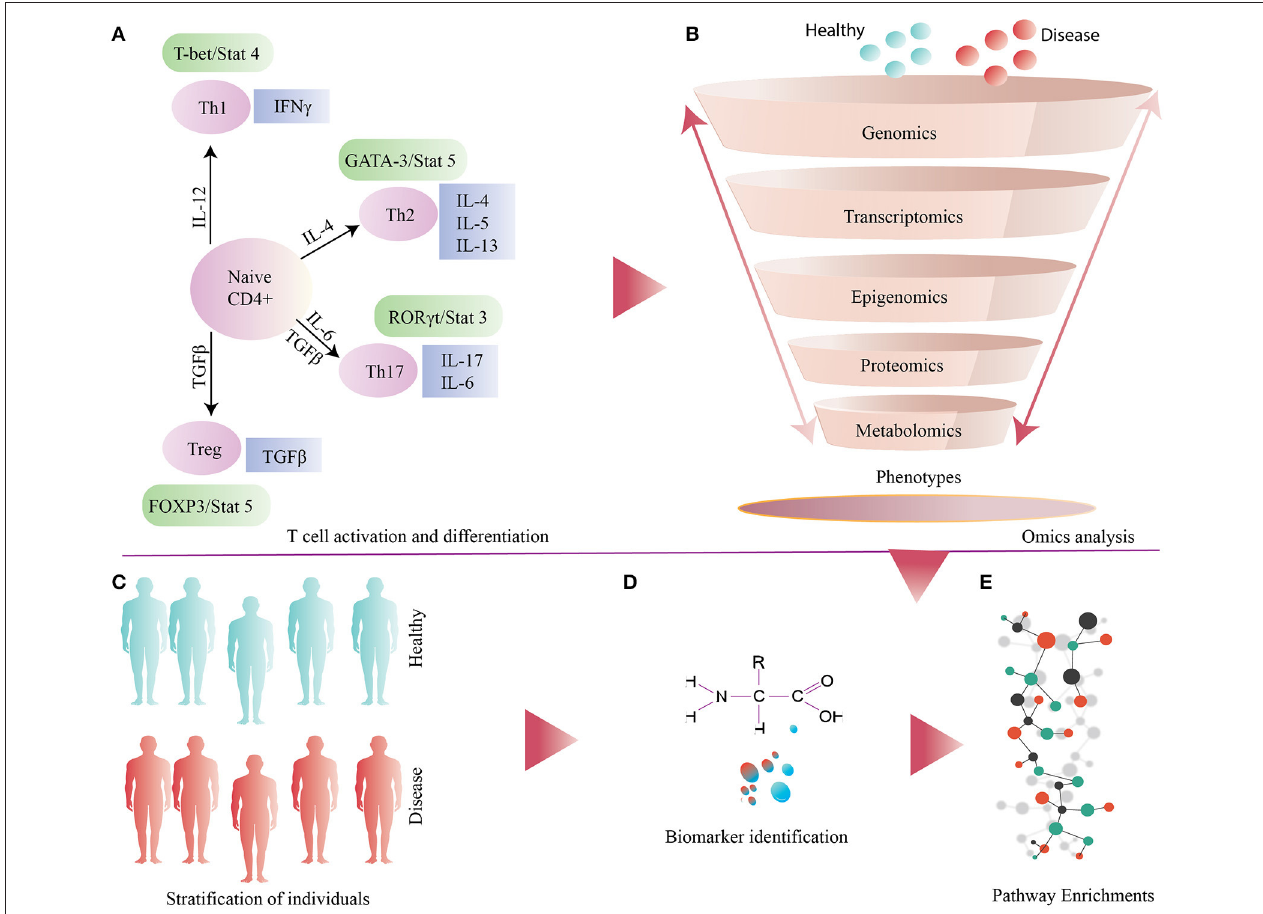
FIGURE 1 | (A) General illustration of T cell activation and differentiation. (B) Several omics based approaches applied to samples obtained from disease and healthy individuals (controls). (C) Stratification of individuals based on metabolic phenotype. (D) Identification and validation of biomarkers. (E) Down-stream analysis of omics datasets for identification and enrichments of differential